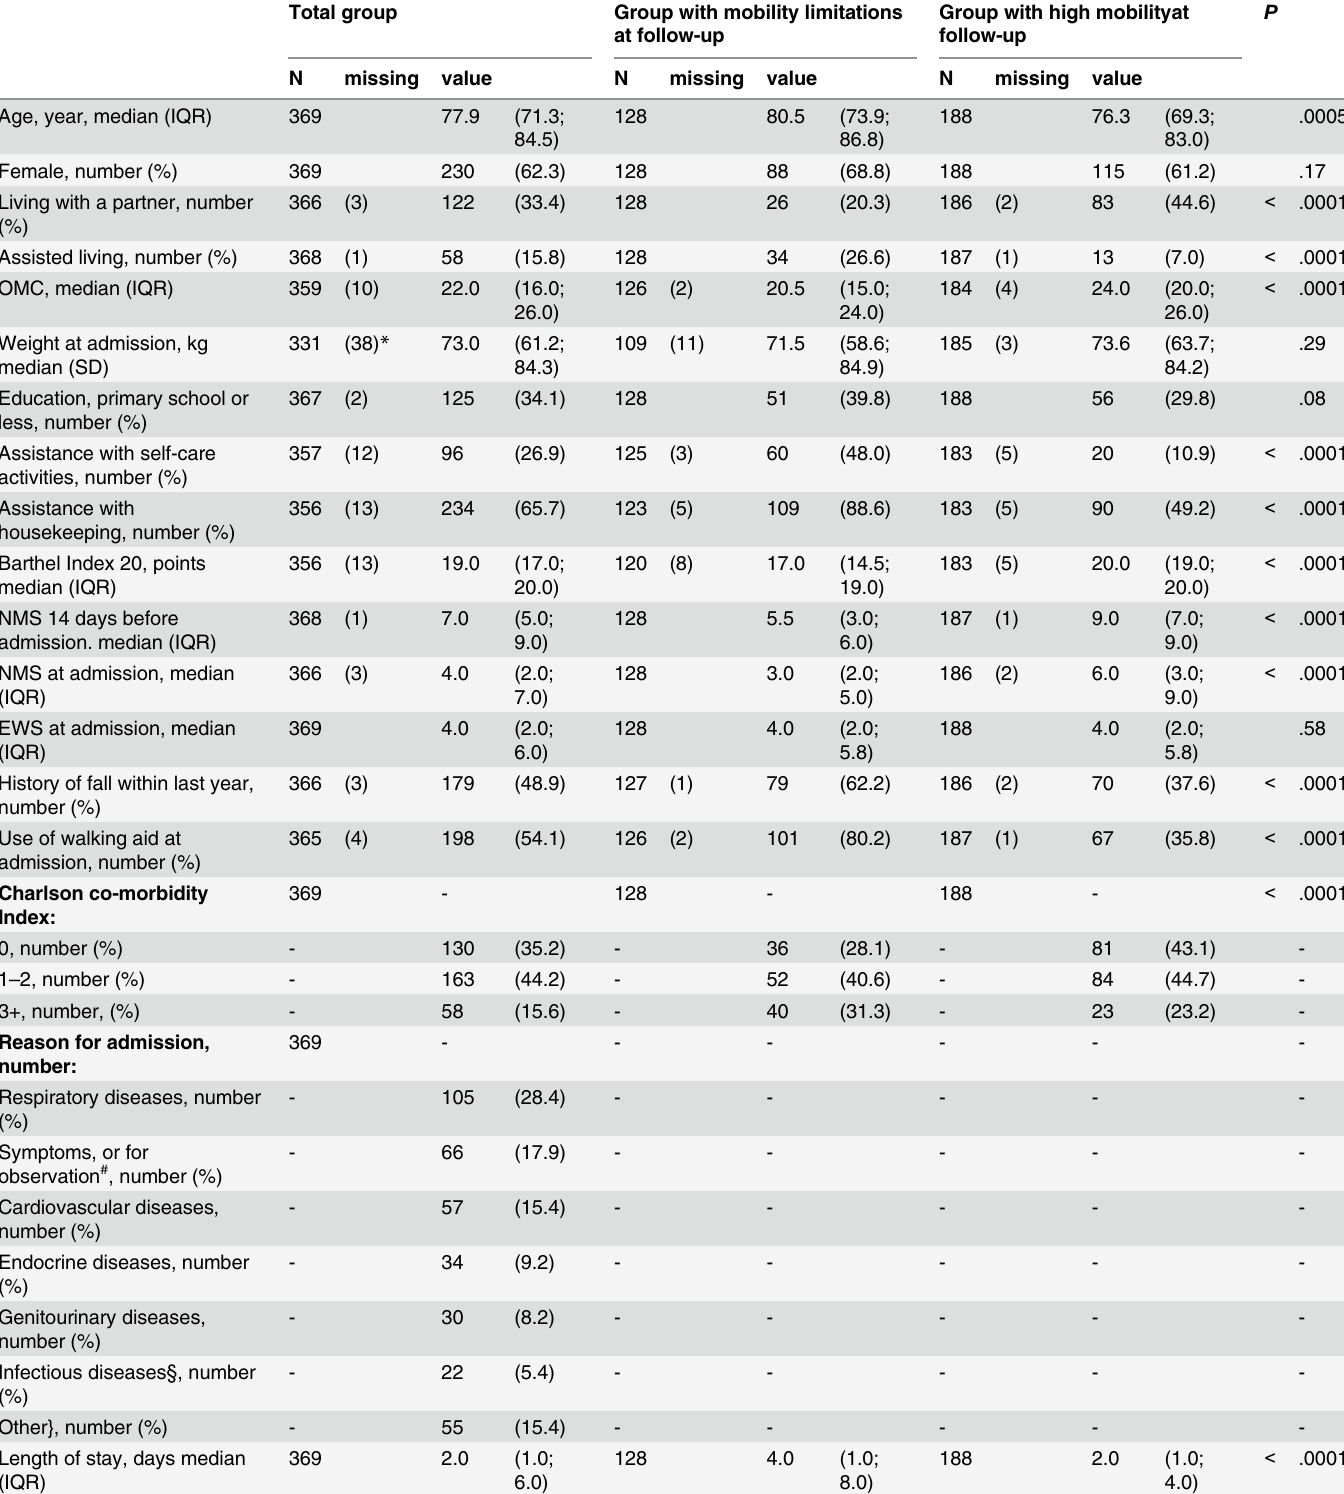
Table 1. Characteristics of the included older medical patients. Total group Group with mobility limitations Group with high mobilityat at follow-up